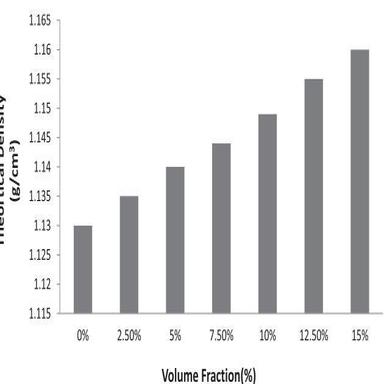
Theoretical density of pure epoxy and epoxy + wool.